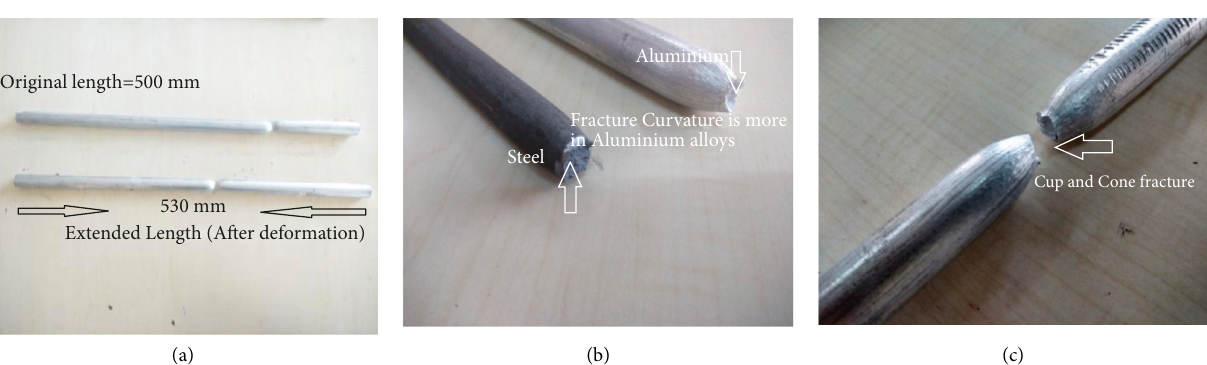
Figure 4: Brinell hardness testing.